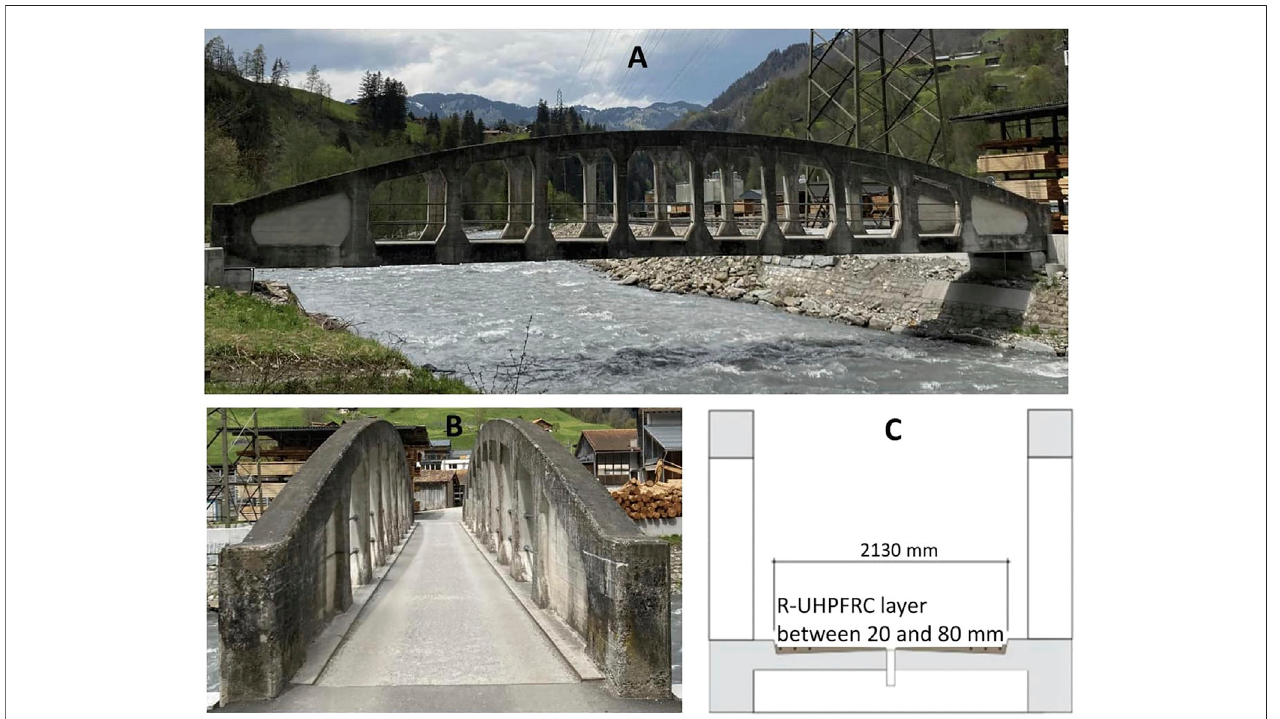
FIGURE 7 | Dalvazza Bridge rehabilitated in 2008. (A) , (B) Photographs of the Vierendeel structure in 2021 (Photo P. Schiltz); (C) intervention with R-UHPFRC.